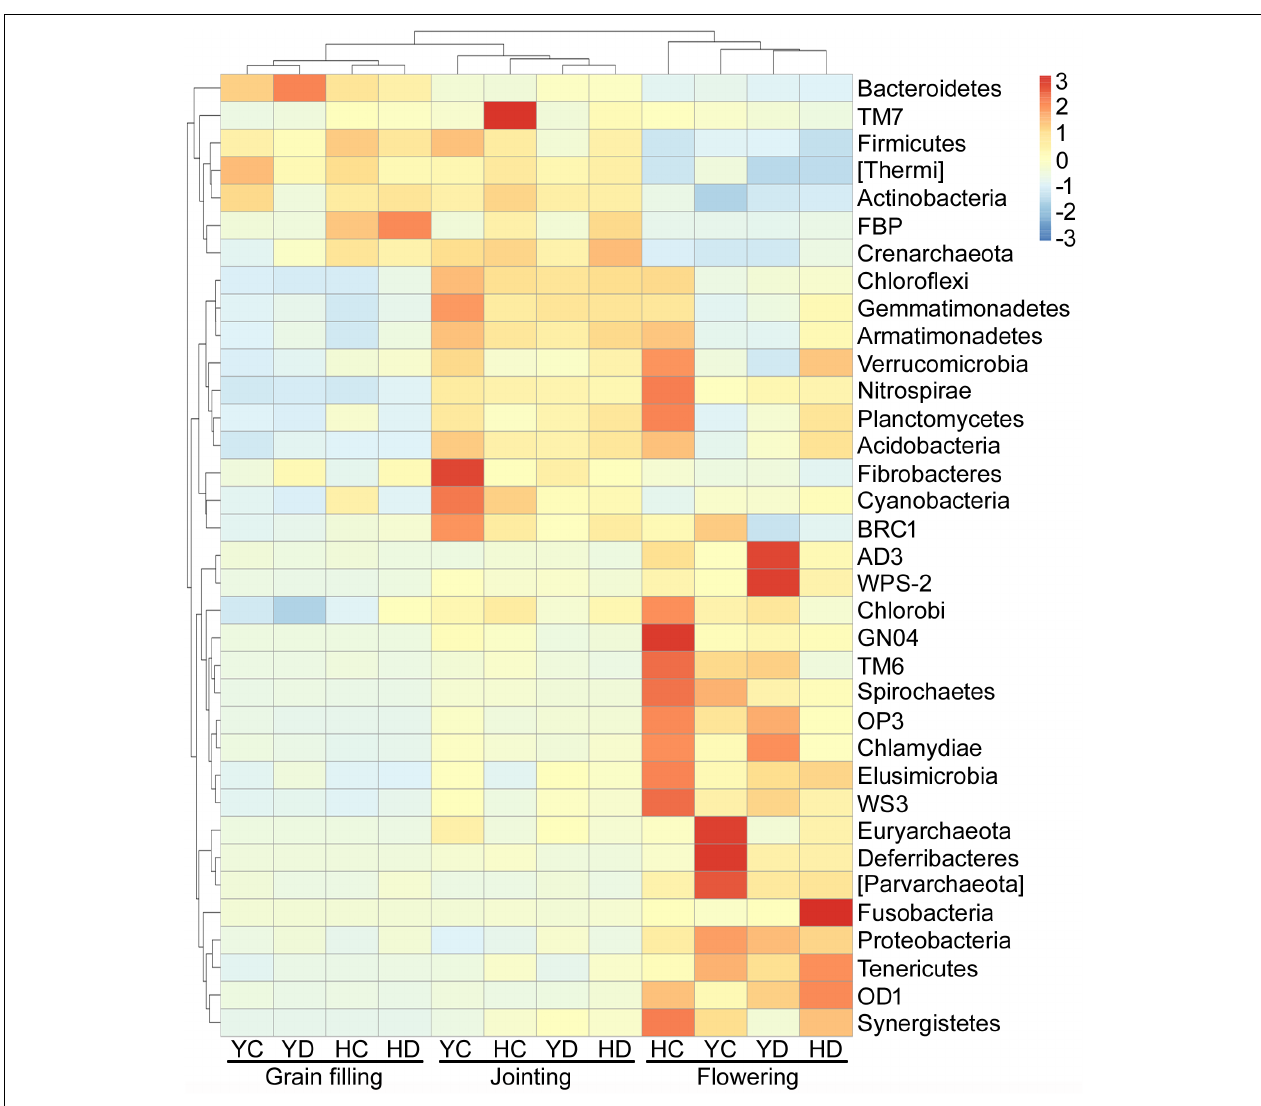
FIGURE 2 | Distribution heat map of bacterial phyla arranged in terms of the developmental stage of broomcorn millet. H = HQR; Y = YL10; C = control, D = drought stress.